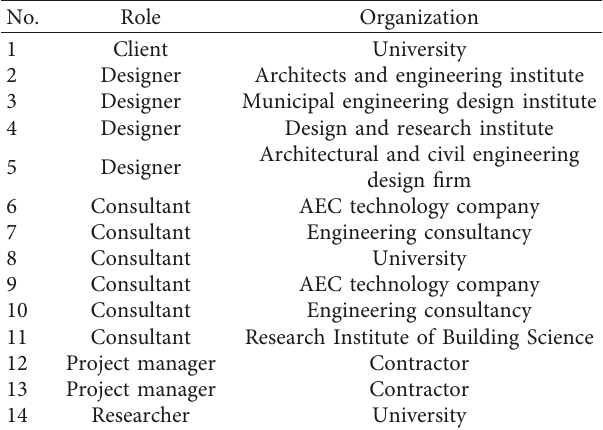
Table 3: Overview of Interviewees: features of respondents in